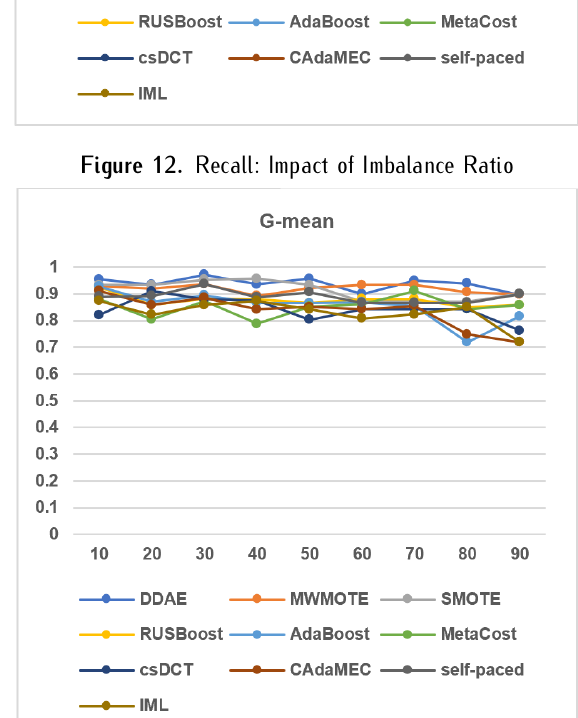
Figure 12. Recall: Impact of Imbalance Ratio